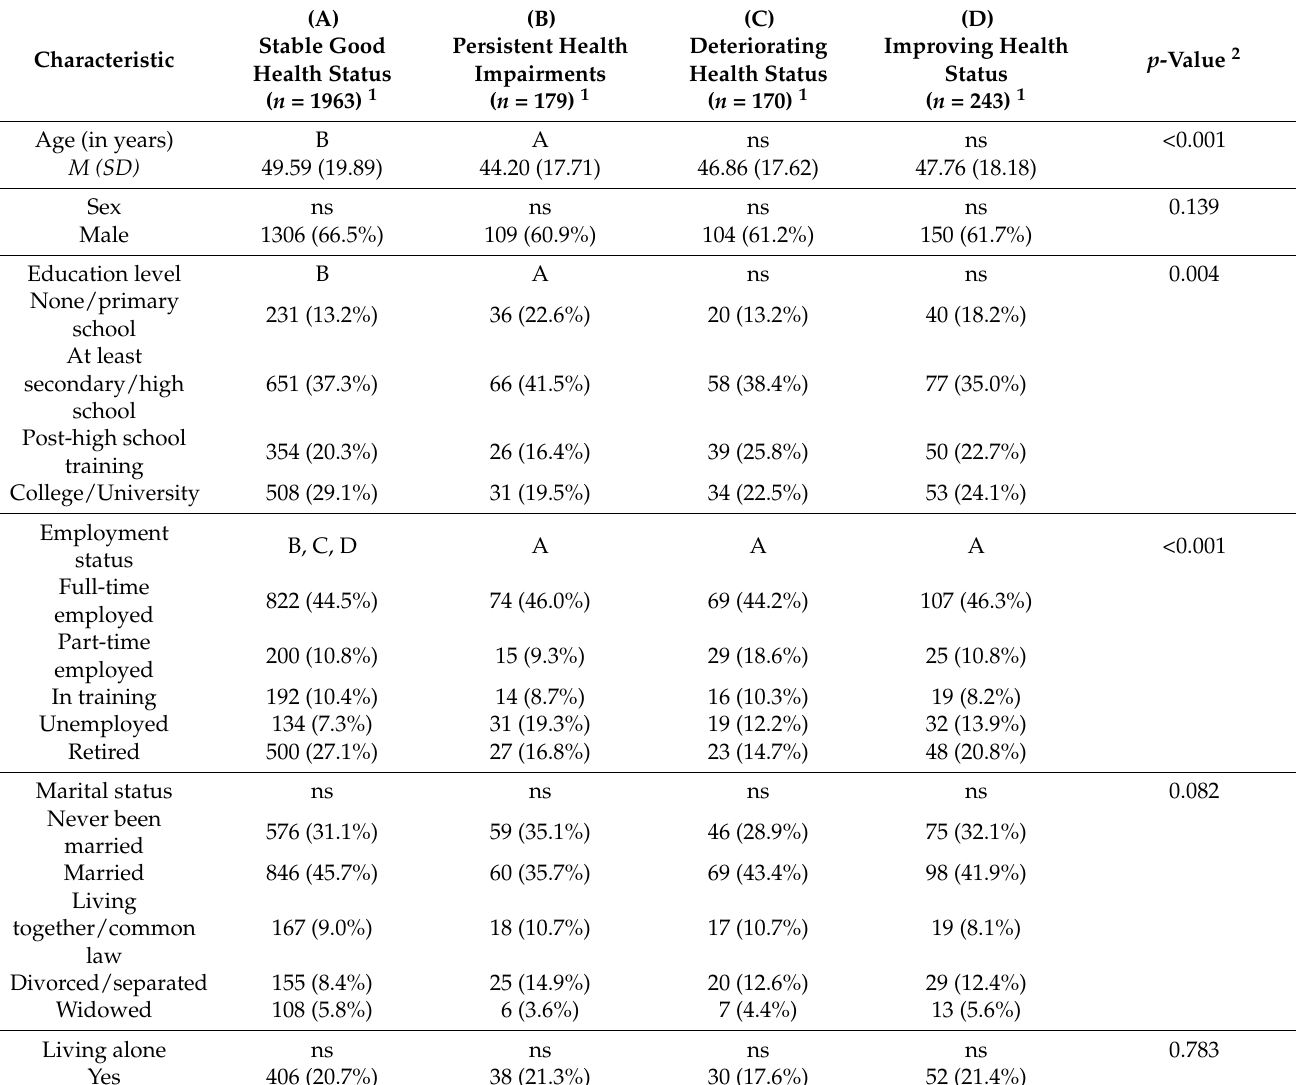
Table A13. Descriptive sociodemographic statistics for the four classes of symptom